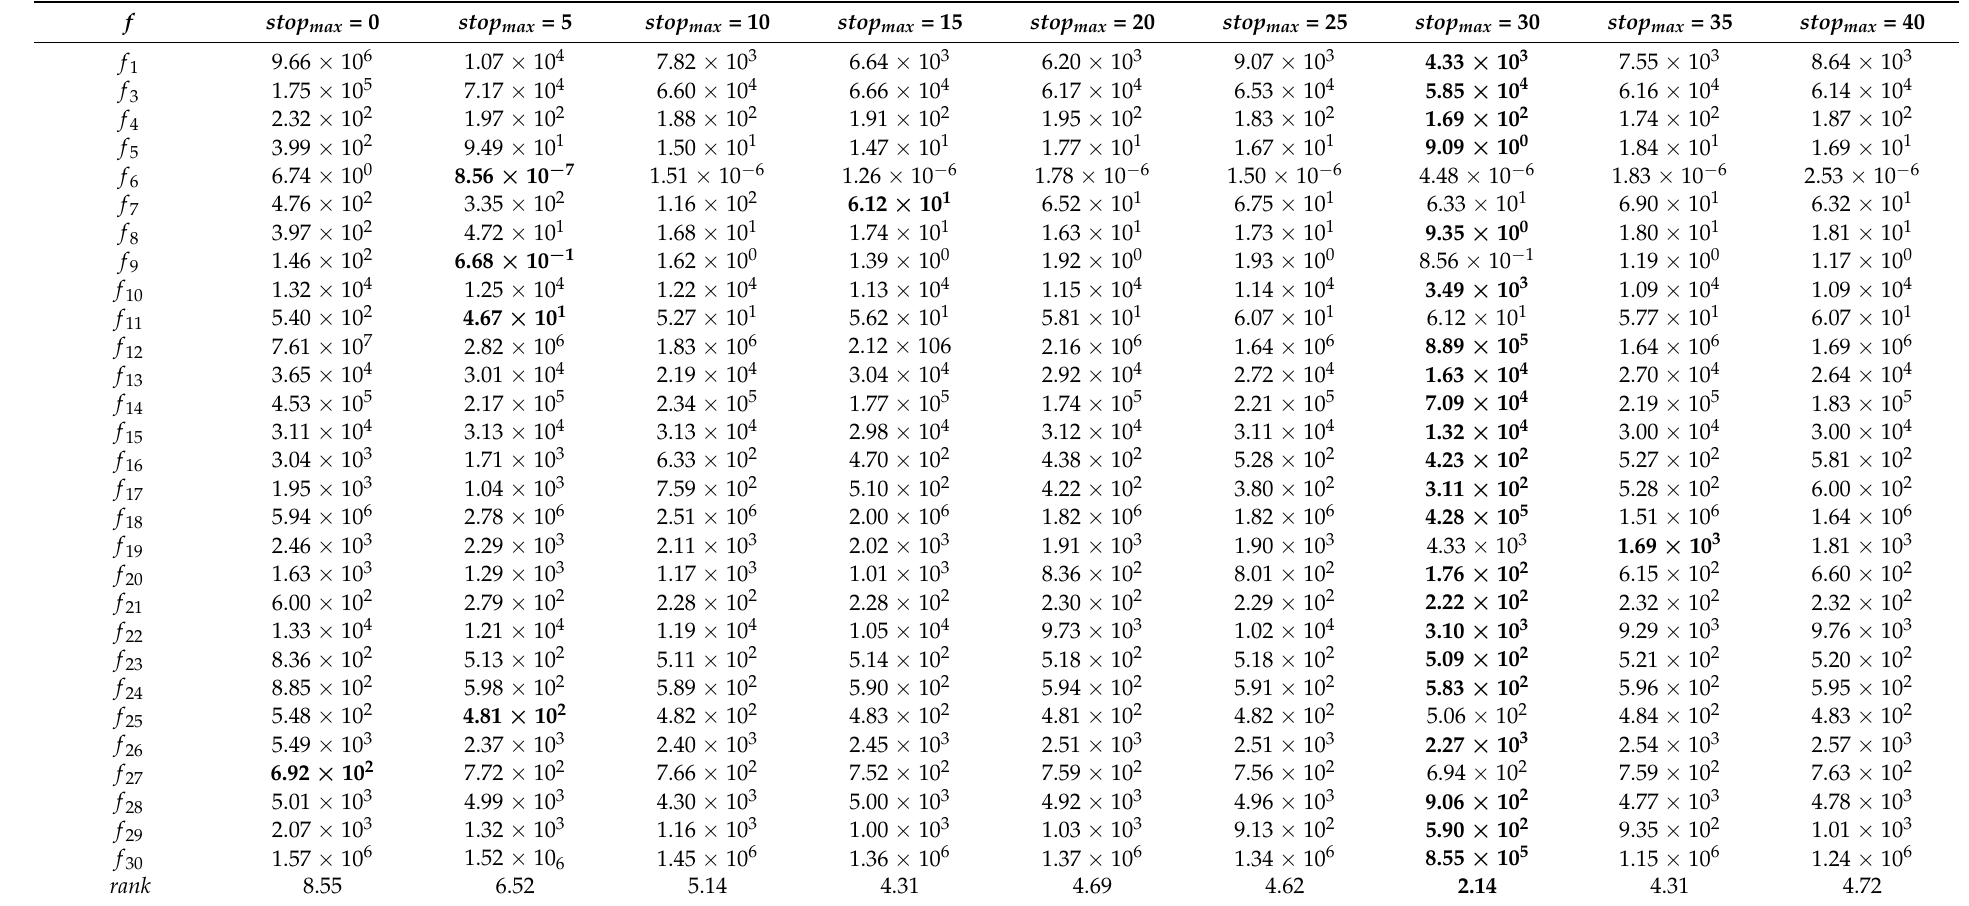
Table 7. Comparison results between STTPSO with different settings of stagnation times on the 50 D CEC 2017 functions. The best results are highlighted in